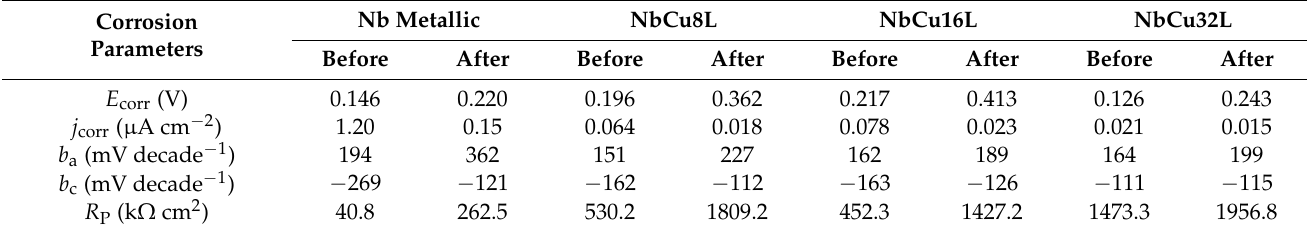
Table 2. Corrosion parameters of metallic Nb and Nb coatings on Cu in 0.005 M H 2 SO 4 + 0.1 ppm F − (pH = 2) before and after polarization at 2 V for 6 h.